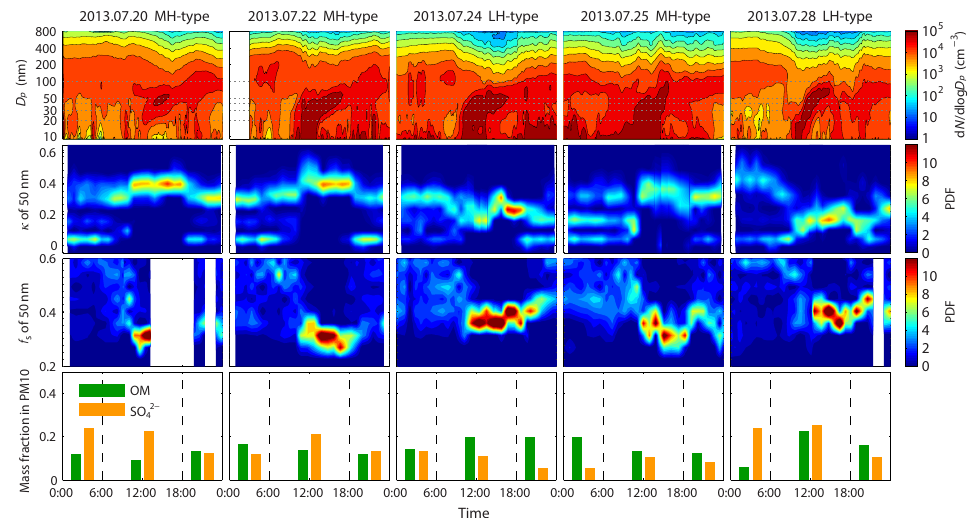
Figure 2. Five NPF events observed during the campaign period. Panels show the time series of particle number size distribution, κ -PDF and f s -PDF of 50nm particles, and mass fraction of organics and sulfate from PM 10 HV-sample